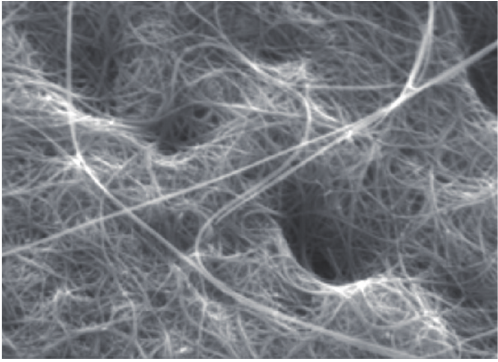
F 2: SEM image of SWCNTs